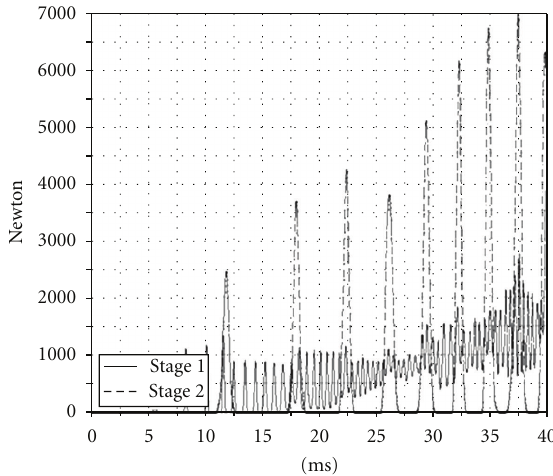
Figure 8: Comparison of the force magnitudes on Stage 1 and Stage 2 with step input torque 149.123